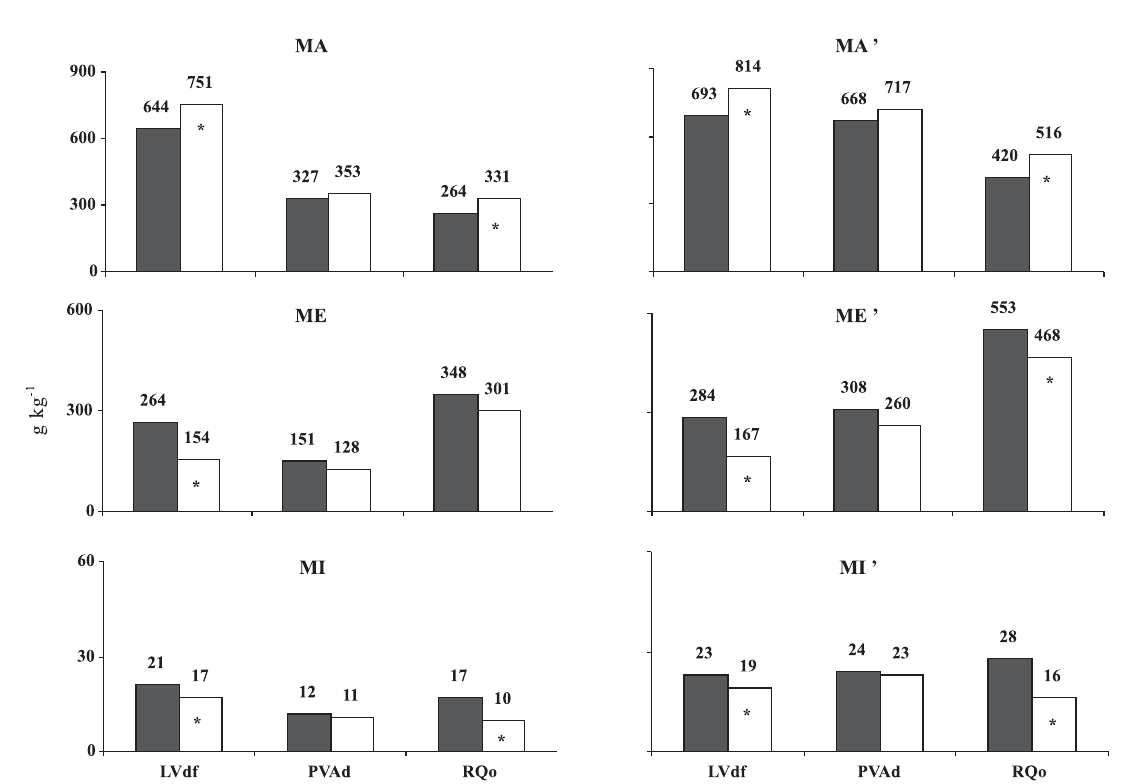
Figura 3. Concentração de agregados estáveis em água do Latossolo Vermelho distroférrico (LVdf), Argissolo Vermelho-Amarelo distrófico (PVAd) e Neossolo Quartzarênico órtico (RQo) sob os manejos com queima (Cq) e sem queima (Sq) de canavial. As notações MA, ME, MI e MA’, ME’, MI’ significam macroagregados, mesoagregados e microagregados em proporção ao solo total e em proporção ao solo livre de areia, respectivamente. * Diferença estatística entre tratamentos no mesmo solo, de acordo com o teste t